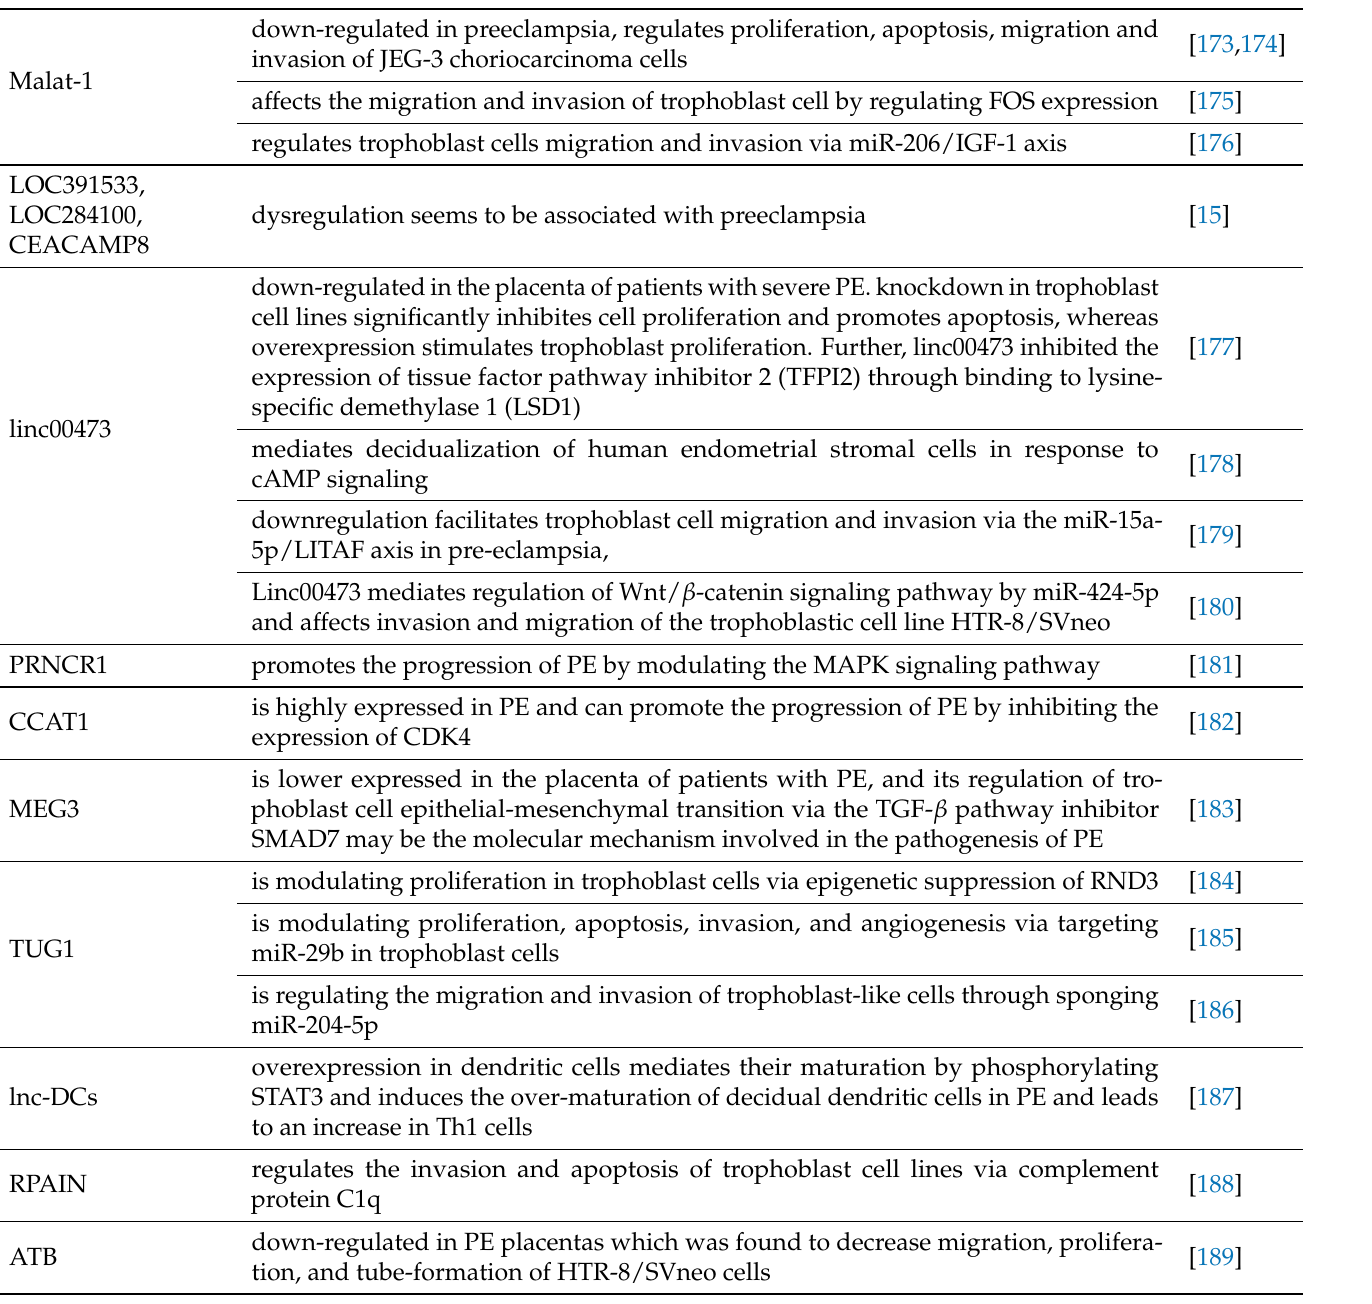
Table 3. Long non-coding RNAs involved in pathologies. NN—no